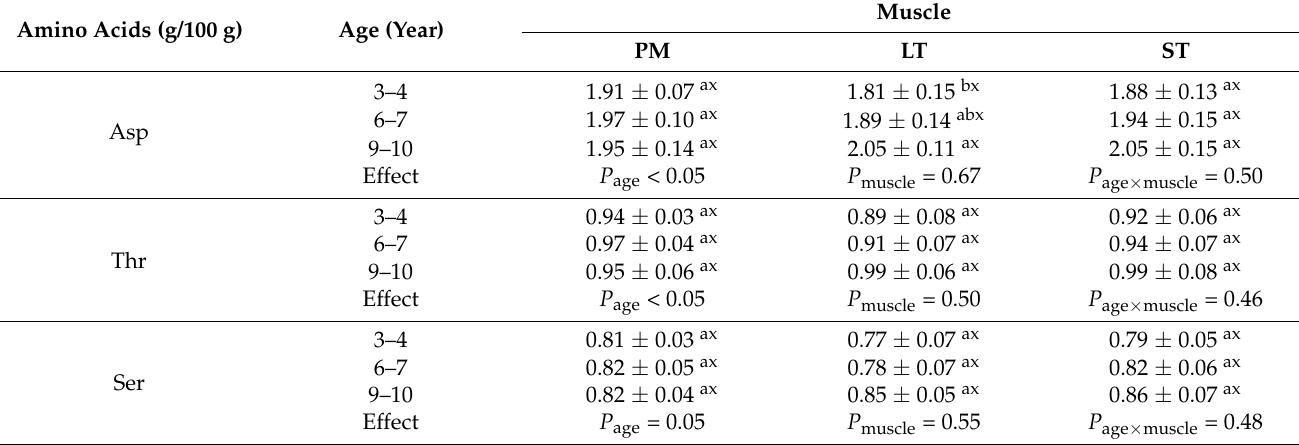
Table 2. Comparison of the amino acid content in Longissimus thoracic (LT), Semitendinosus (ST), and Psoas major (PM) muscle samples from Alxa Bactrian camels ( n = 5, mean ± standard error) slaughtered at three different